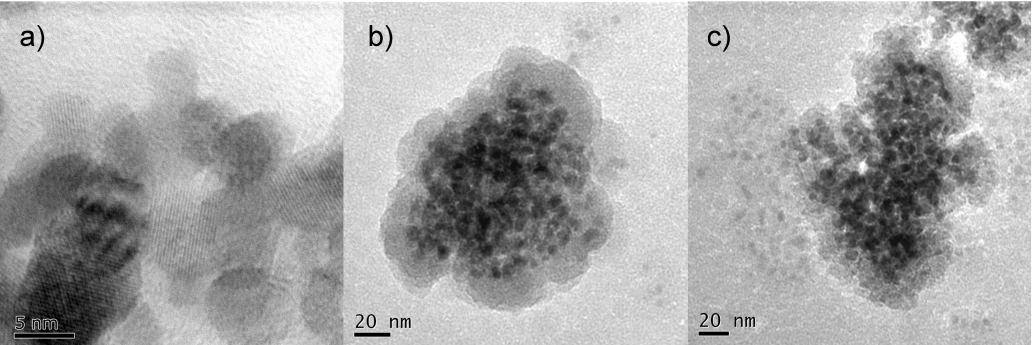
Figure 1. Examples of nano-sized zirconia particles differing in the degree of crystallinity: ( a ) fully crystallized ZrO 2 /calcined 400 °C, 40 min, in air; ( b ) partially crystallized ZrO 2 -Eu 3+ 8 wt% doped, short and ( c ) long heating treatments (MSS).